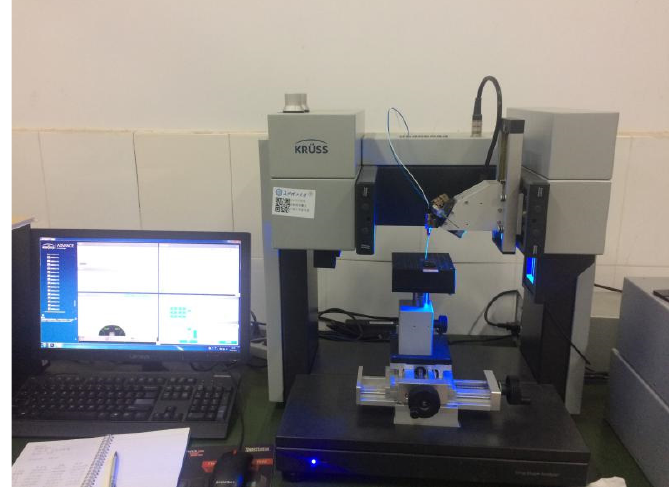
Figure 5. Contact angle meter.